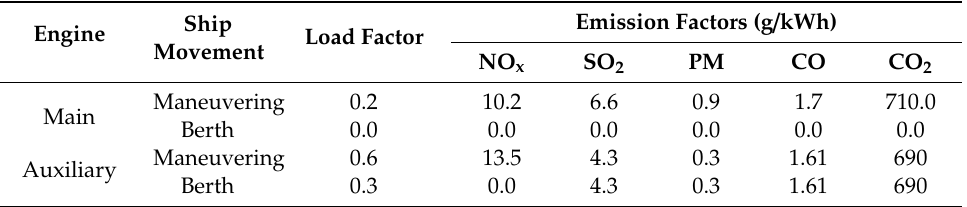
Table 3. Emissions factors for passenger ships at Piraeus port ([46,57]).